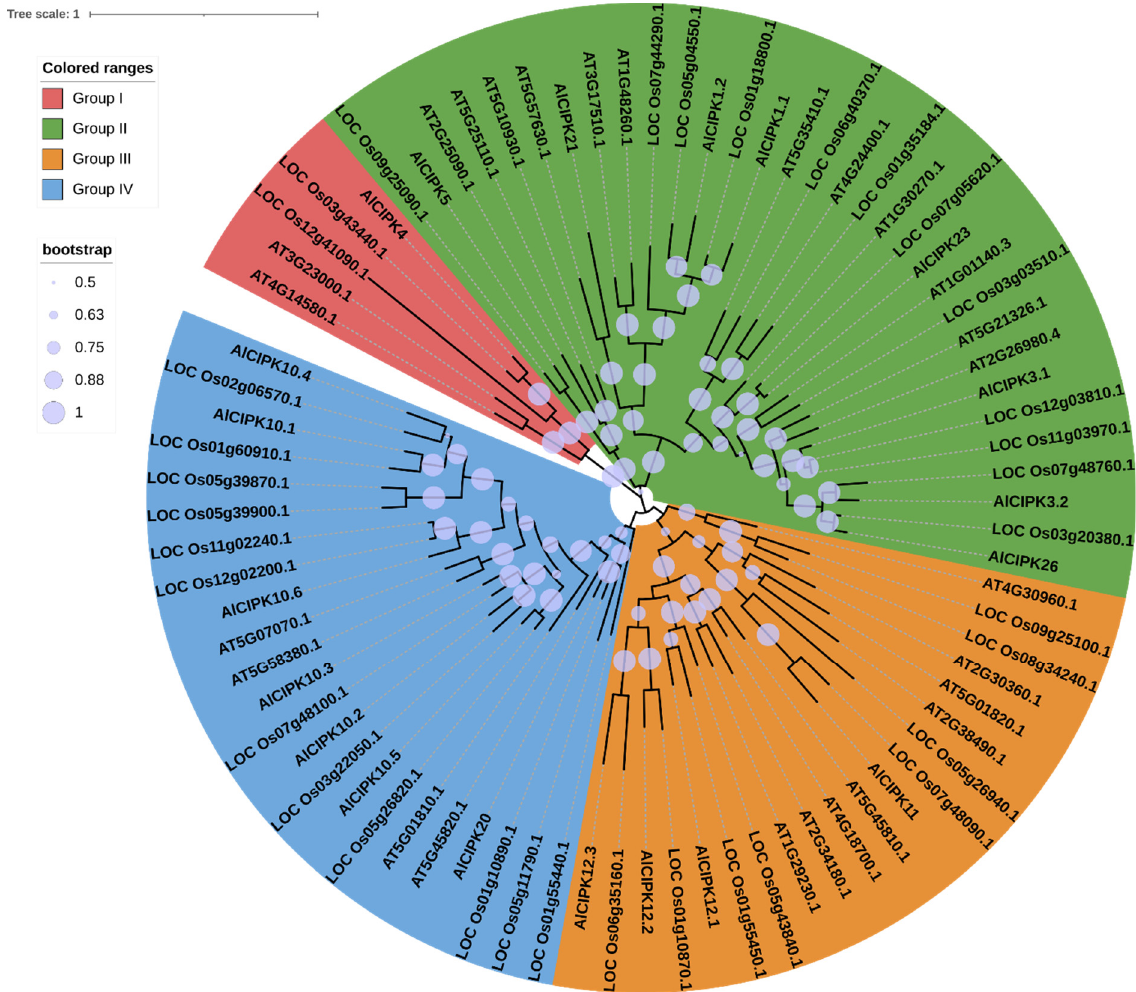
Figure 2. Phylogeny tree of CIPK family proteins in A. littoralis (AlCIPK), rice (started with LOC), and Arabidopsis (started with AT). The phylogenetic tree was drawn using the maximum likelihood (ML) method with 1000 bootstrap replications.